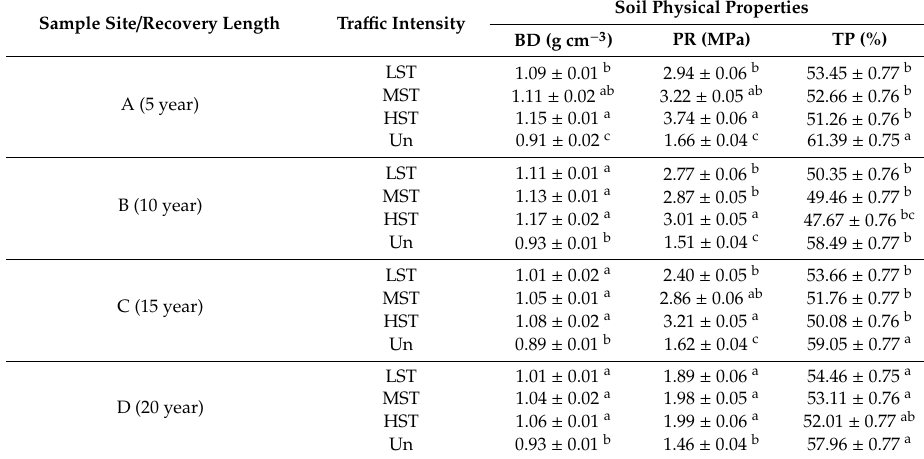
Note: Di ff erent letters indicate statistically significant di ff erences within columns for each tra ffi c intensity separately ( p < 0.01), based on analysis of variance (GLM).